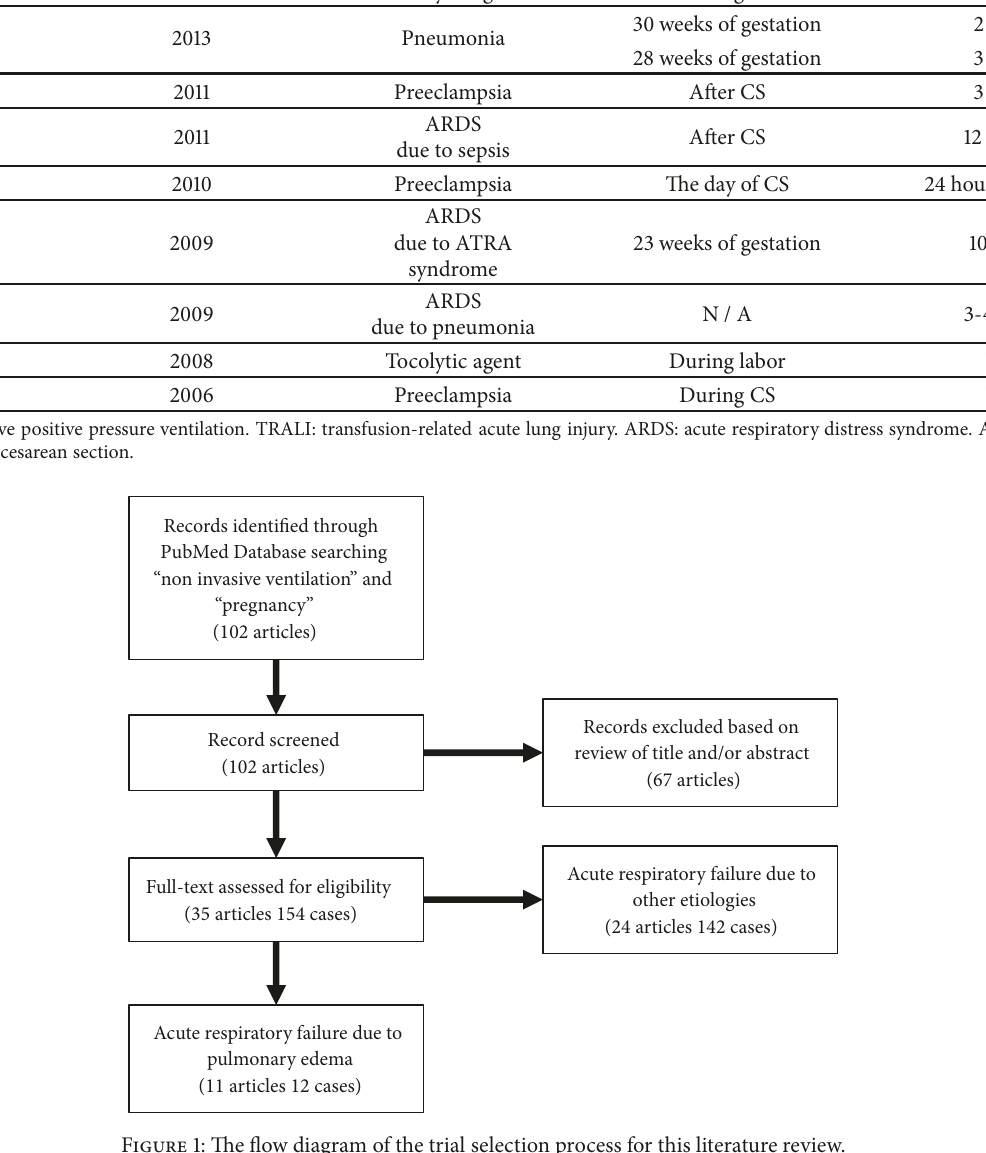
Figure 1: The flow diagram of the trial selection process for this literature